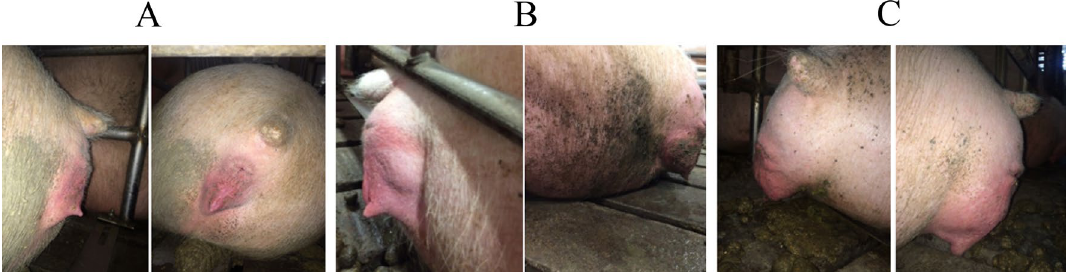
Figure 7. Perineal scoring (PS) methodology as an indicator of pelvic organ prolapse (POP). The perineal region was visually evaluated for swelling, redness and protrusion to assign scores. ( A ) If a sow lacked swelling, redness and protrusion they were considered low risk for POP and assigned as PS1. ( B ) Sows with some characteristics such as moderate swelling, redness and protrusion of the perineal area were considered moderate risk for POP and assigned as PS2. ( C ) Sows demonstrating all of the characteristics of severe swelling, redness and protrusion of the perineal area were assigned to the PS3 category and considered high risk for